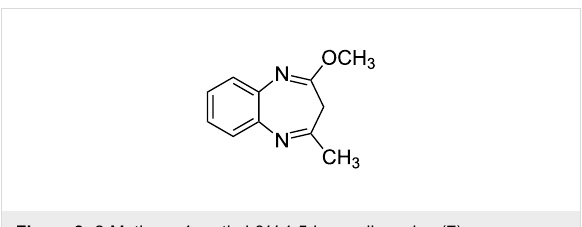
Figure 8: 2-Methoxy-4-methyl-3 H -1,5-benzodiazepine ( 7